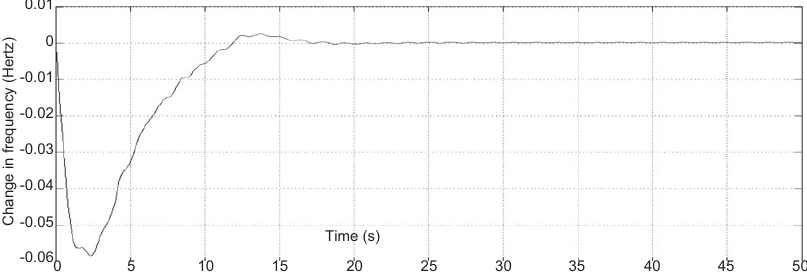
Figure 10. Change in Frequency (Thermal Plant): With Fuzzy Controller.